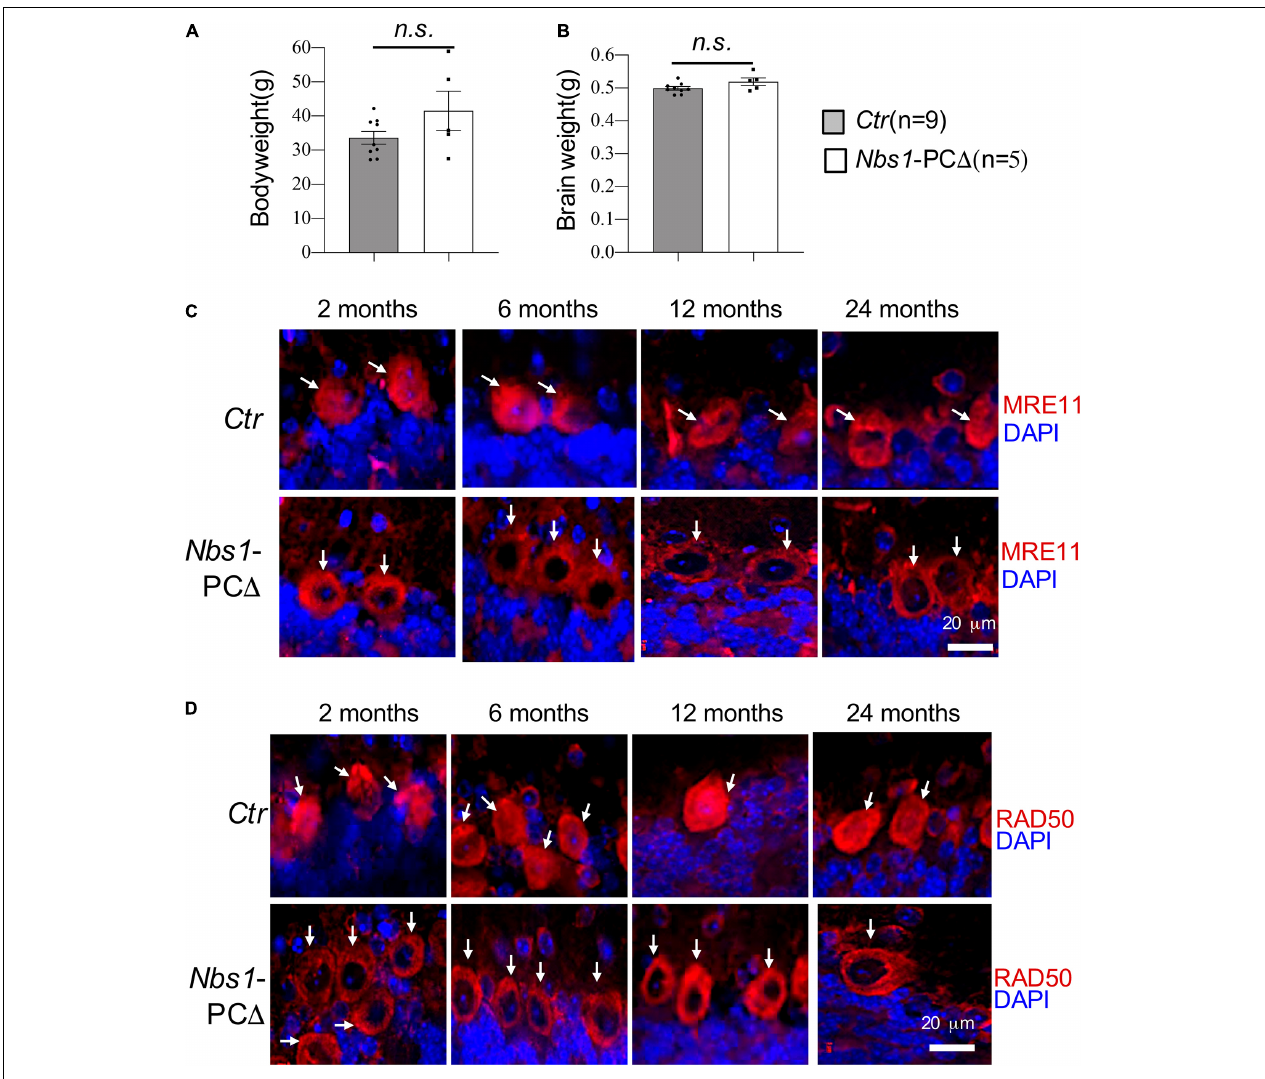
FIGURE 1 | Deletion of Nbs1 is compatible with mouse survival and cerebellar development. (A) Bodyweight of 20 ∼ 24 months old mice from the indicated group. (B) Brain weight of the animal for panel (A) , Error bars indicate the value mean ± SEM; n.s., not significant. Data comparison was performed through Student’s t -test. (C,D) Deletion of Nbs1 in Purkinje cells leads to dislocation of MRE11 and RAD50. Sagittal cryo-sections of control ( Ctr ) and Nbs1 -PC (cid:49) mice at the indicated age were stained with anti-MRE11 (C) and anti-RAD50 (D) antibodies together with DAPI to label nuclei. The Purkinje cell layer in the cerebellum region is shown. Scale bars: 20 µ m. Representative images of sections from two mice are shown. Arrows point to Purkinje